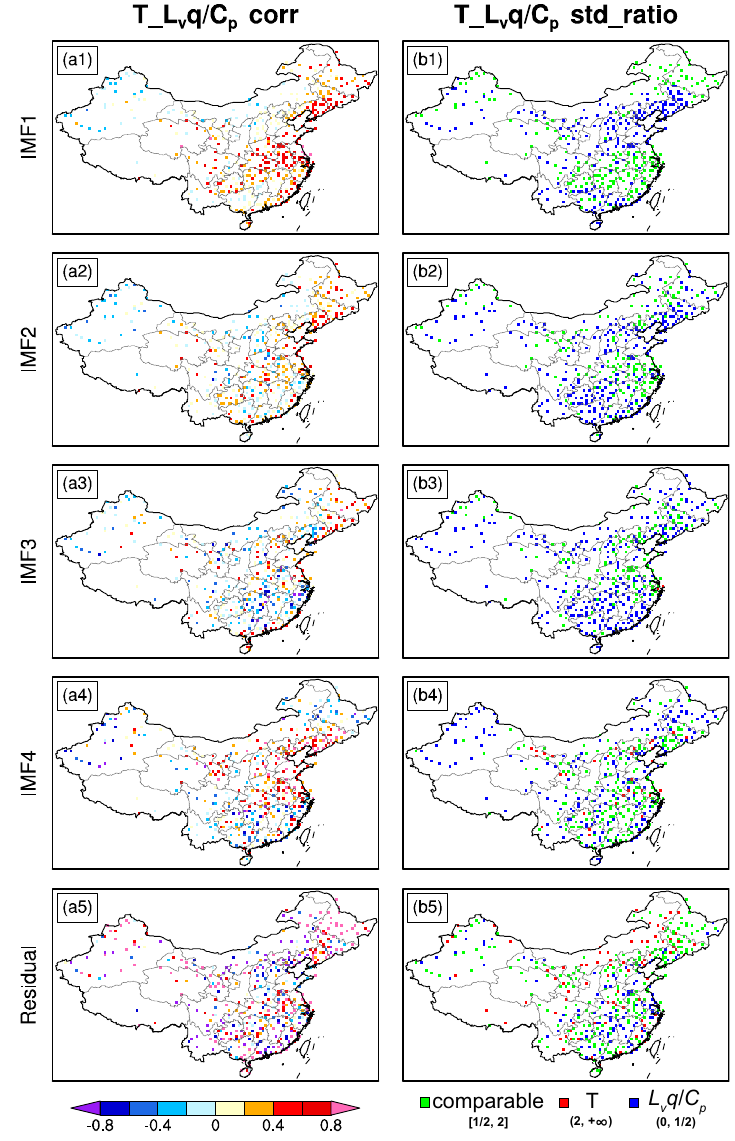
Figure 7. The correlation coefficients between T and LH terms (left column: ( a )), and the ratio of the standard deviations (STDR) of T and LH (right column: ( b )) at different ensemble empirical mode decomposition (EEMD) modes (rows 1–5). Note that the green, red and blue points in column b represent that the variability of T and the variability of LH are comparable (0.5 ≤ STDR ≤ 2), the variability of T dominated the variability of T e (STDR > 2) and the variability of LH dominated the variability of T e (STDR < 0.5), respectively.